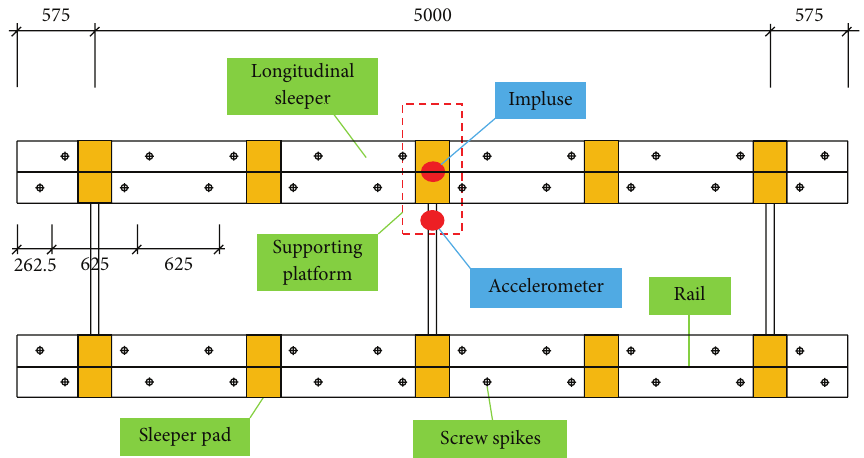
Figure 3: Plan of the test ladder track (unit: mm).